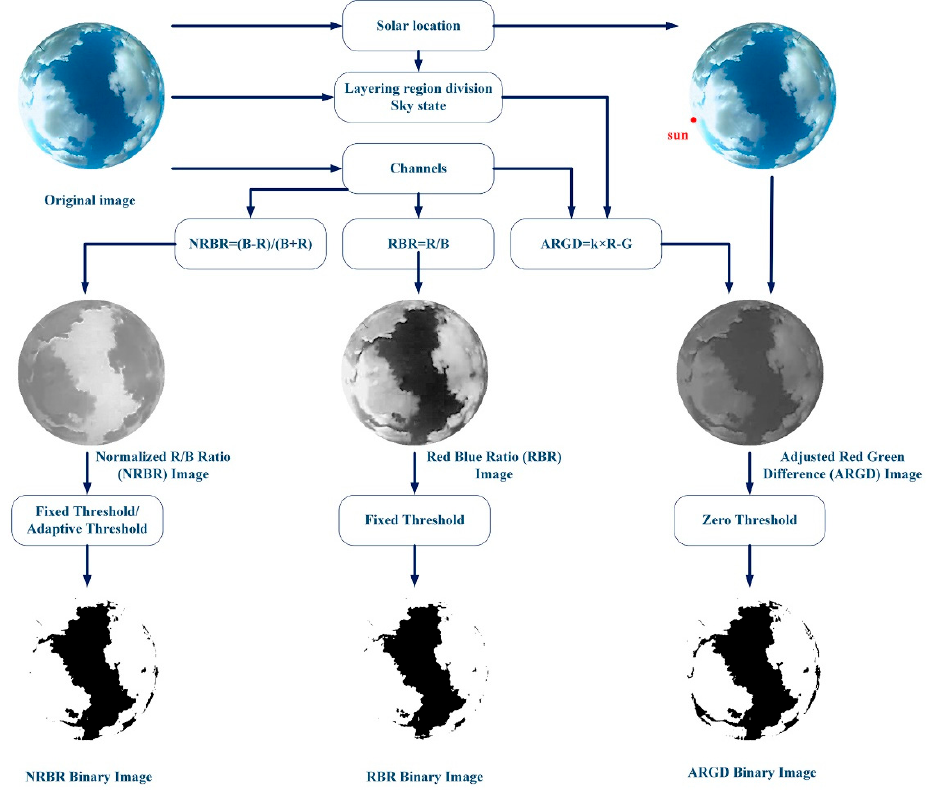
Figure 3. System framework and comparison of features (adjustable red green difference (ARGD), normalized red/blue ratio (NRBR), and red blue ratio (RBR)).